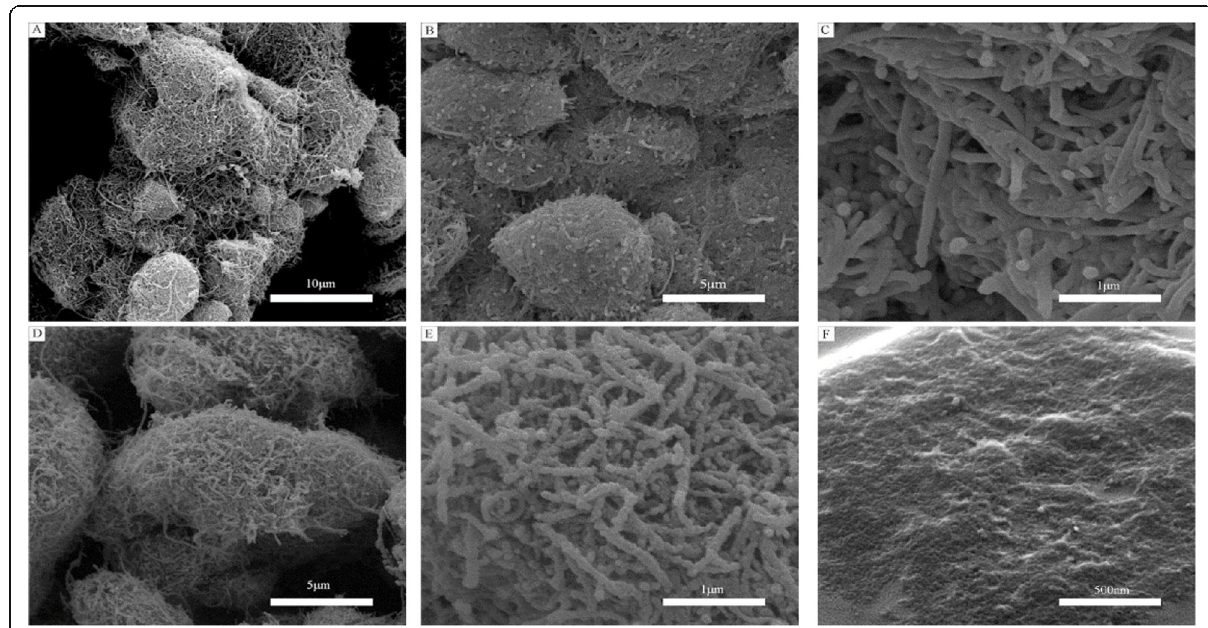
Fig. 3 FESEM images of a pristine carbon nanotubes; b , c carbon nanotubes with oxidation treatment; d , e CNTs/SnO 2 nanocomposite; and f CNTs/SnO